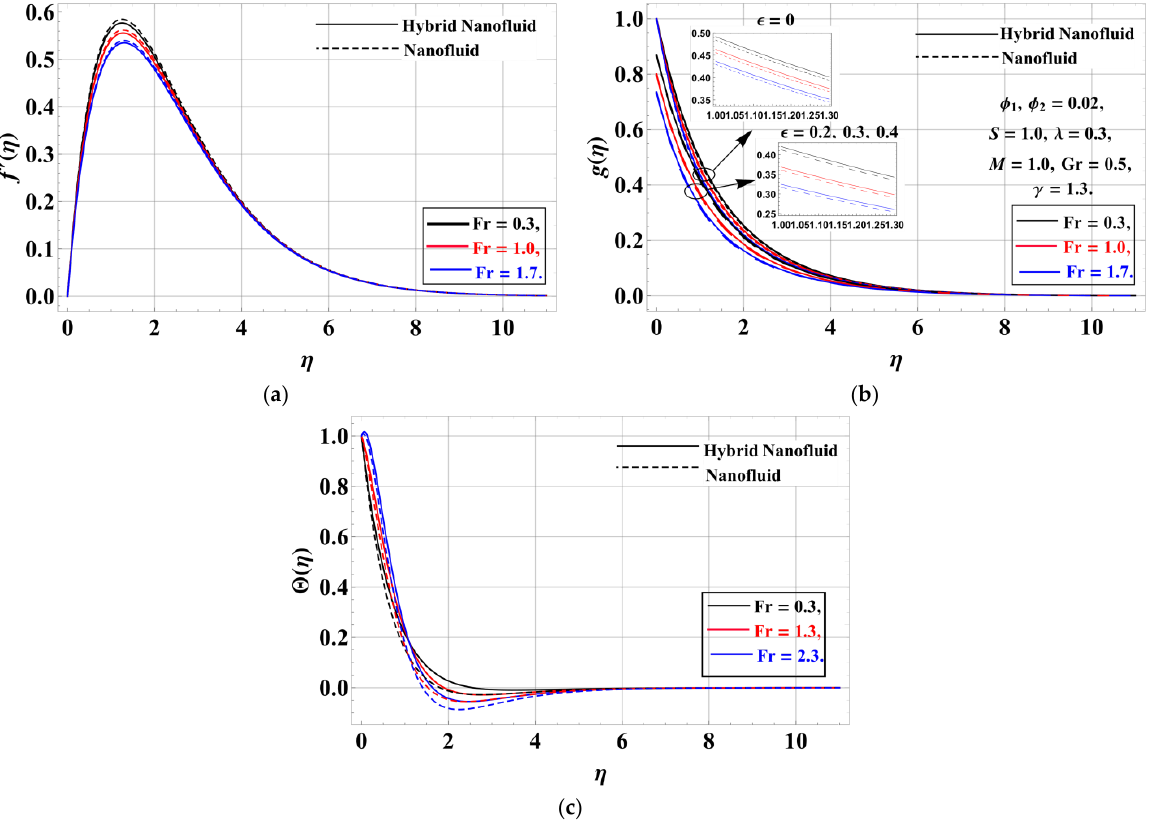
Figure 3. Variations in f (cid:48) ( η ) , g ( η ) & Θ ( η ) against Fr . ( a ) Variations in f (cid:48) ( η ) against Fr ( b ) Variations in g ( η ) against Fr ( c ) Variations in Θ ( η ) against Fr . The variation of the porosity parameter λ is elaborated in Figure 4a,b against radial and azimuthal velocity profiles when all the other parameters are kept as φ 1 , φ 2 = 0.02, Fr = 0.3, M = 1, S = 1, Gr = 0.5, & ε = 0. It is perceived that the porosity parameter decreases in both directions for the velocity components. Since the porosity parameter restricts the flow of the fluid on the surface of the disk, raising the value of the porosity parameter causes the width of the boundary layer to rise, which results in the velocity falling. This is because the growth in the porous medium resists the flow of fluid, resulting in flow retardation as depicted in Figure 4a,b. Figure 4c displays the effect of the porosity factor on temperature distribution for γ = 0, Ec = 0.3, Pr = 0.3, & Rd = 0.3. When the permeability of the porosity parameter is increased, then the temperature of the fluid rises, as portrayed in Figure 4c.